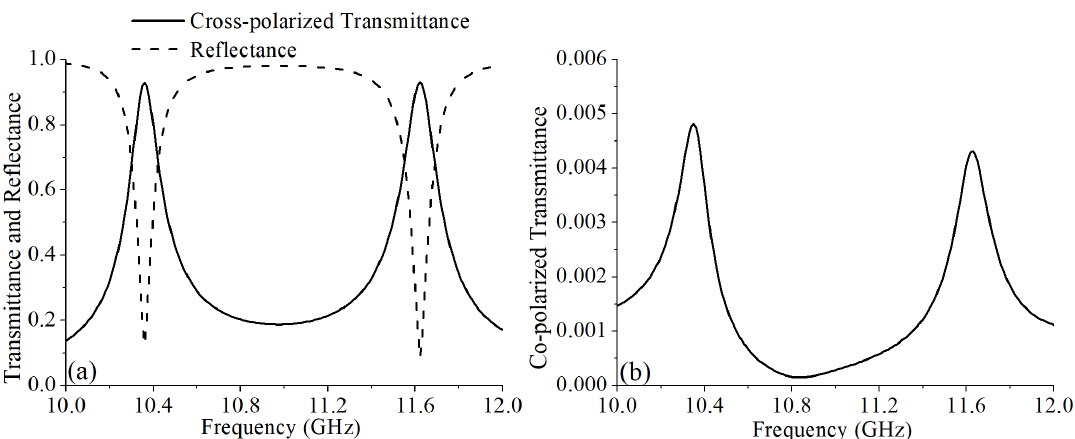
Figure 2. ( a ) The simulated cross-polarized transmittance and reflectance. ( b ) The simulated co-polarized transmittance.